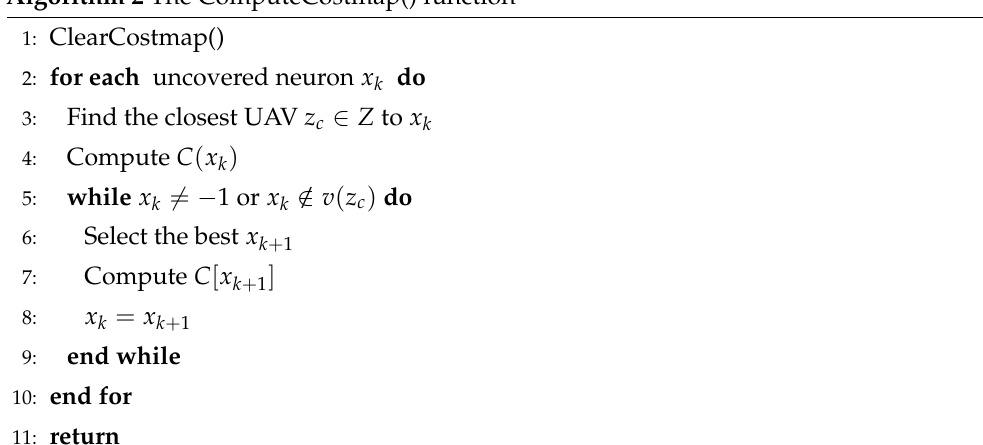
Algorithm 2 The ComputeCostmap()